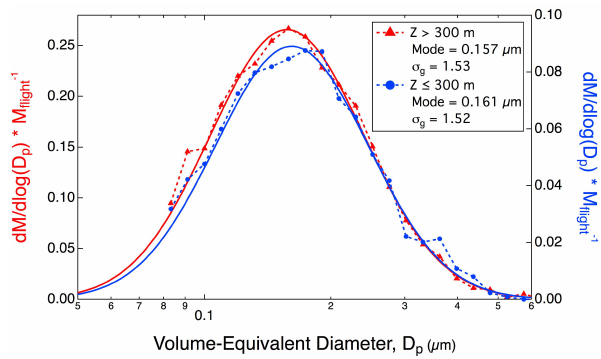
Fig. 4. Mass size distributions for BC aerosol in the ABL (blue) and free troposphere (red) on 12 April 2008. The free tropo- spheric data include the full altitude profiles immediately before (84698–86798s, UTC) and after (87827–89447s) the ABL flight segment (86799–87826s). The flight context for these distributions can be seen more clearly from the time series in Fig. 5. The free tro- pospheric segments bracket the ABL profiles in Fig. 6B. The size distributions have been normalized by the total measured BC mass for the flight (M flight ). The modes and geometric standard devi- ations ( σ g ) are reported for the lognormal fits (solid lines) to the data.